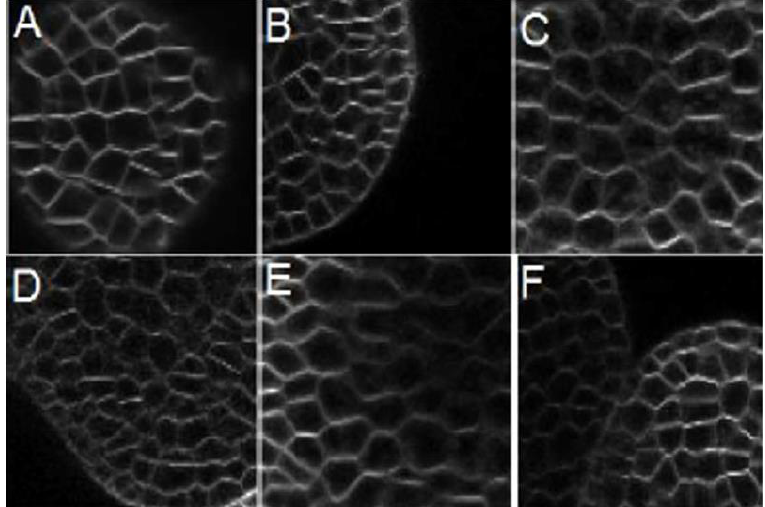
Figure 13. Sub-images taken from each image of Figure 1 and employed to compare the meristem segmentation methods described here. Table 6. Results obtained with the meristem segmentation methods.